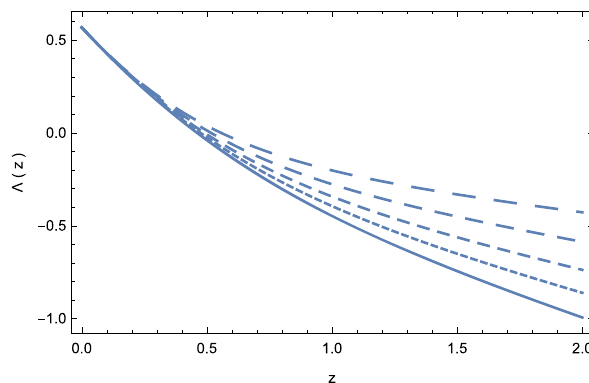
Fig. 2 Variationasafunctionoftheredshiftofthedecelerationparam- eter q ( z ) for the geometry-matter coupling function F α ˜ Q + β ˜ T for α = − 1 . 95, M = 0 . 95, and for different values of β : β = − 2 . 64(dottedcurve), β = − 2 . 78(shortdashedcurve), β = − 2 . 91 (dashed curve), β = − 3 . 07 (long dashed curve), and β = − 3 . 24 (ultra- long dashed curve). To integrate the system of cosmological evolution equations we have used the initial conditions h ( 0 ) = 1, (cid:18)( 0 ) = 0 . 555, and (cid:4)( 0 ) = 0 . 568. The solid curve represents the evolution of the deceleration parameter in the standard (cid:4) CDM cosmological model